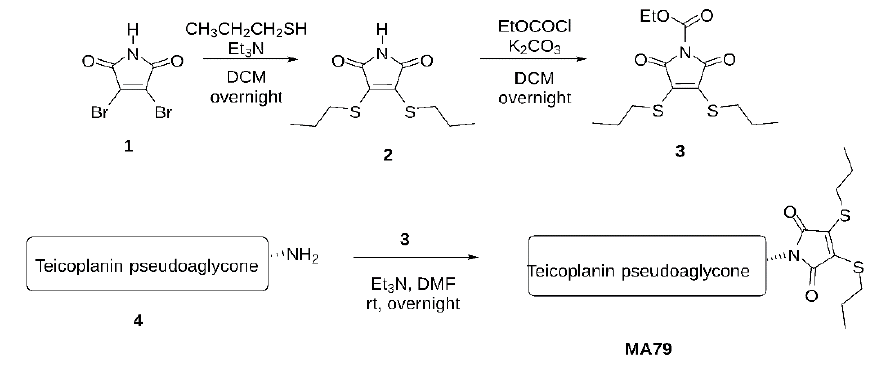
Figure 8. Schematic representation of MA79 synthesis.